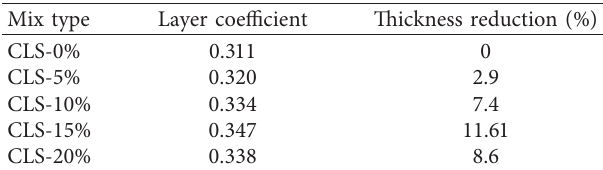
Table 9: Thickness reduction results based on resilient modulus